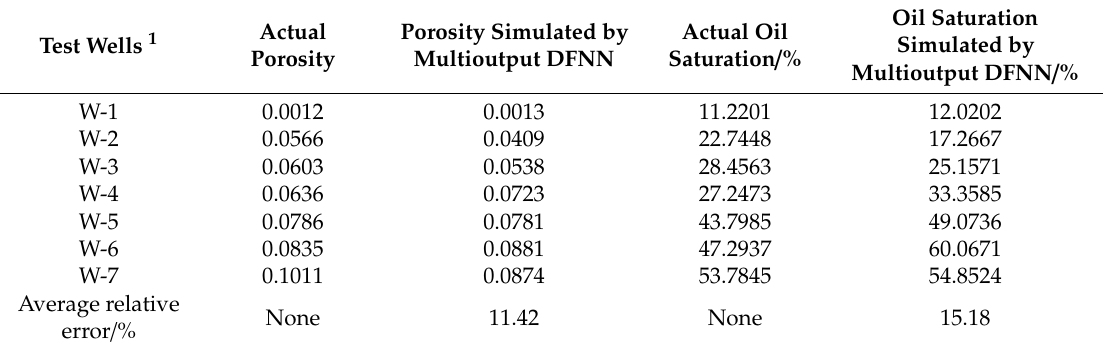
1 The test wells are randomly selected from X